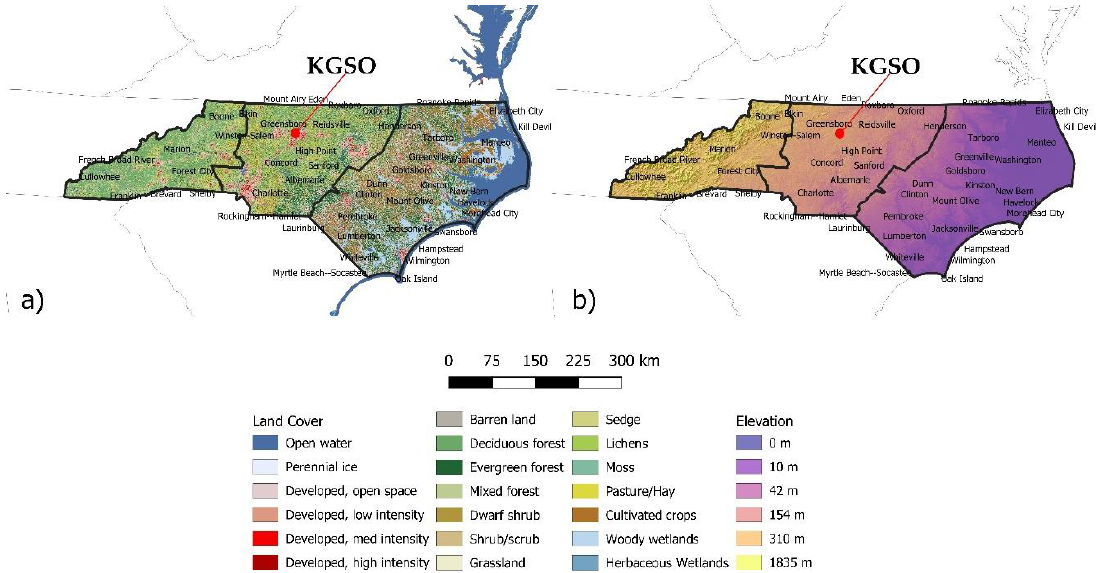
Figure 1. ( a ) National Land Cover Database (NLCD) 2016 data and ( b ) elevation. Three regions are delineated from left to right as western North Carolina, central North Carolina, and eastern North Carolina. Air mass conditions were determined from the Greensboro (KGSO) spatial synoptic classification site.